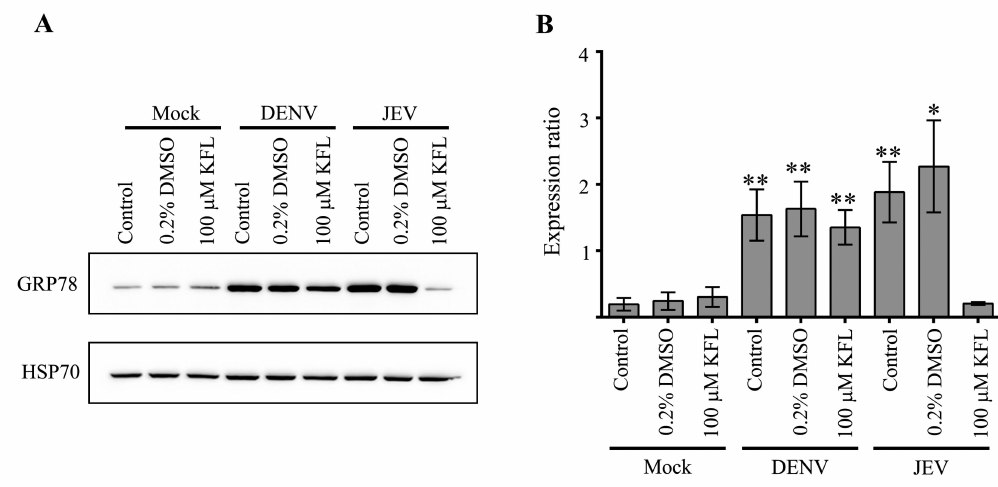
Figure 11. E ff ect of kaempferol treatment on GRP78 expression. BHK-21 cells were mock infected or infected with JEV or DENV 2 and treated with 100 µ M kaempferol, DMSO vehicle or not treated (control) for 24 h. The cells were collected at 24 h post treatment and total proteins were extracted. Western blot analysis was performed to determine the expression of GRP78. Hsp70 was used as an internal protein loading control. Experiments were undertaken independently in triplicate. Error bars represent SD. *; p value ≤ 0.05, **; p value ≤